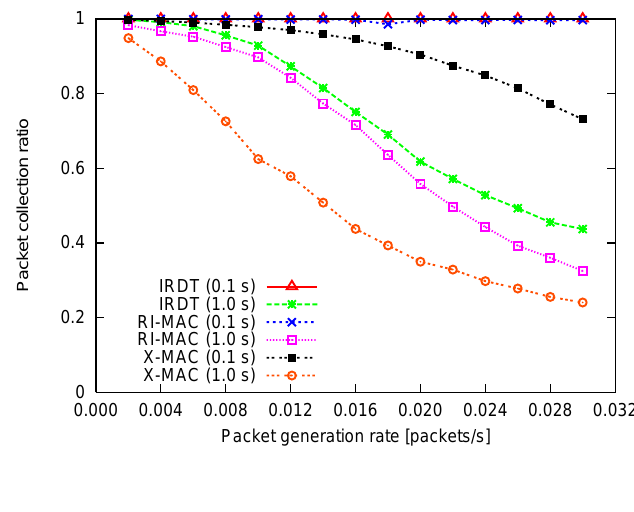
Figure 12. Packet collection